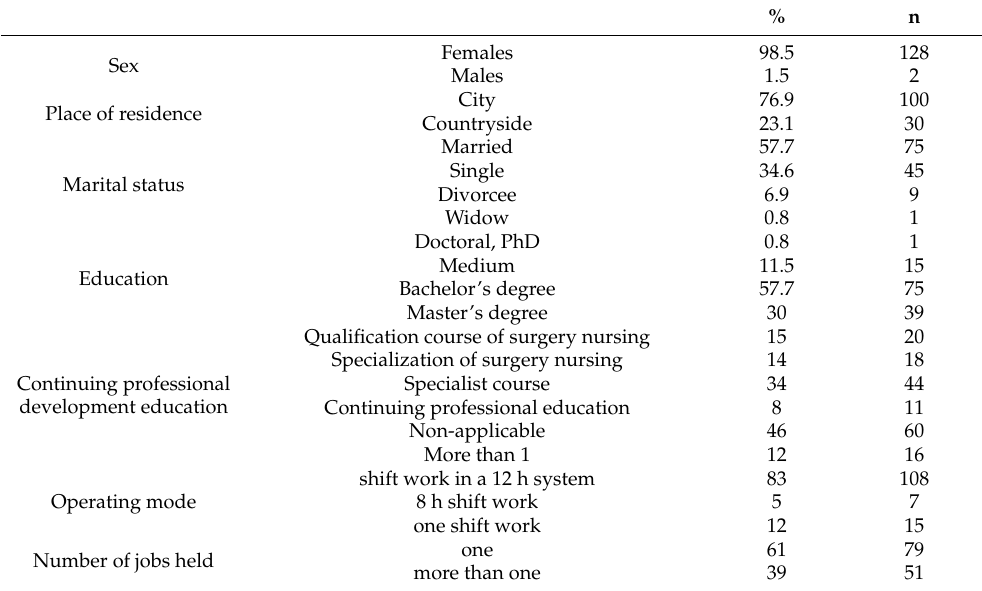
Table 1. Demographic characteristics of